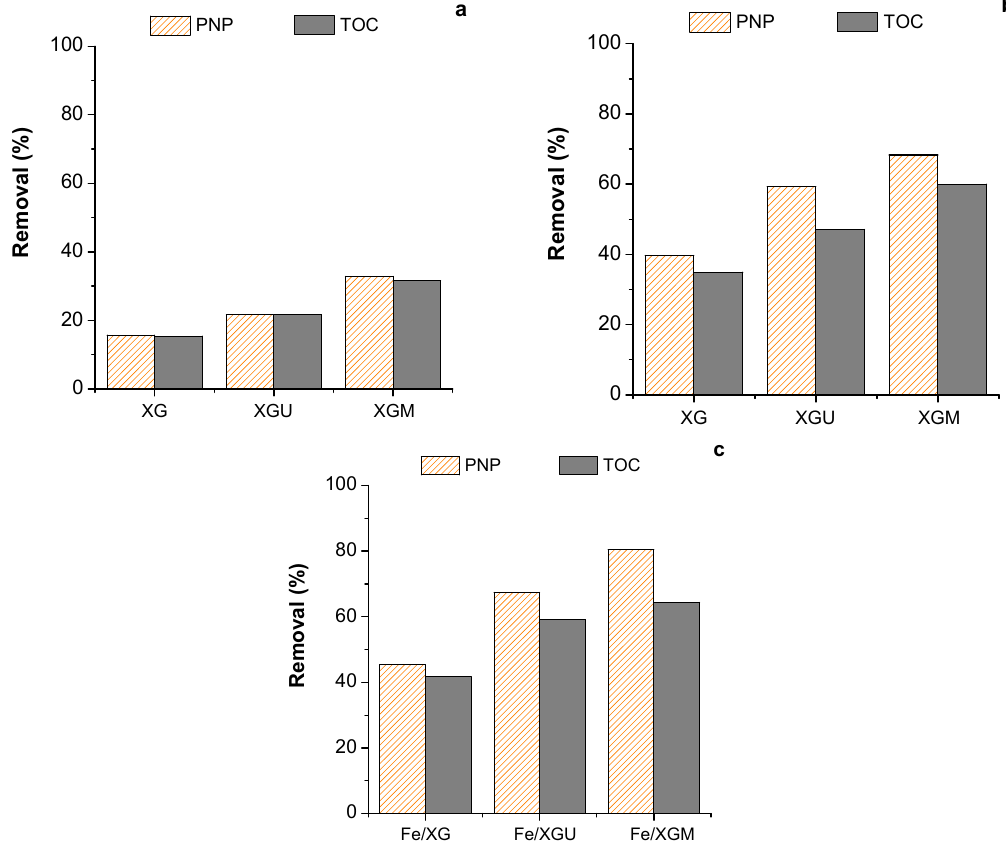
Figure 6. p -nitrophenol (PNP) and total organic (TOC) removal after 2 h of adsorption ( a ) and reaction ( b ) with support carbon xerogels (XG, XGU and XGM) and Fenton’s reaction ( c ) using catalysts (Fe/XG, Fe/XGU and Fe/XGM) (pH = 3.0, T = 30 ◦ C, [support or catalyst] = 0.25 g L − 1 , [H 2 O 2 ] when used = 29 mmol L − 1 , [PNP] = 3.6 mmol L − 1 and H 2 O 2 :PNP molar ratio = 8.1, when H 2 O 2 was used).